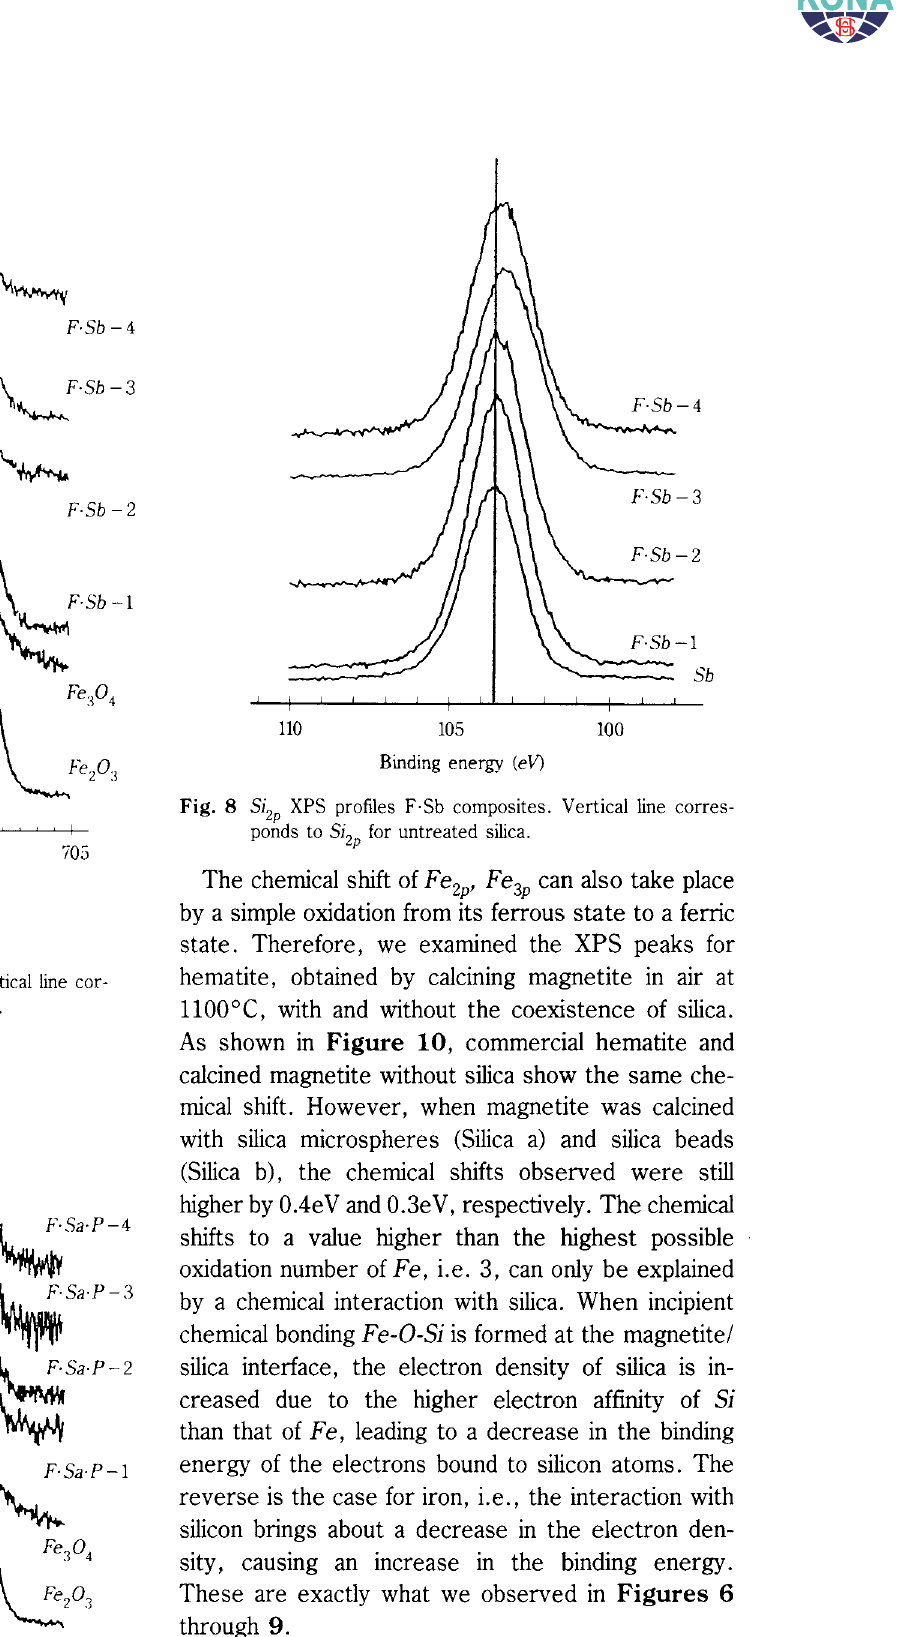
Fig. 6 Fe 2P XPS profiles for F·Sb composites. Vertical line cor responds to Fe 2P312 for untreated magnetite.